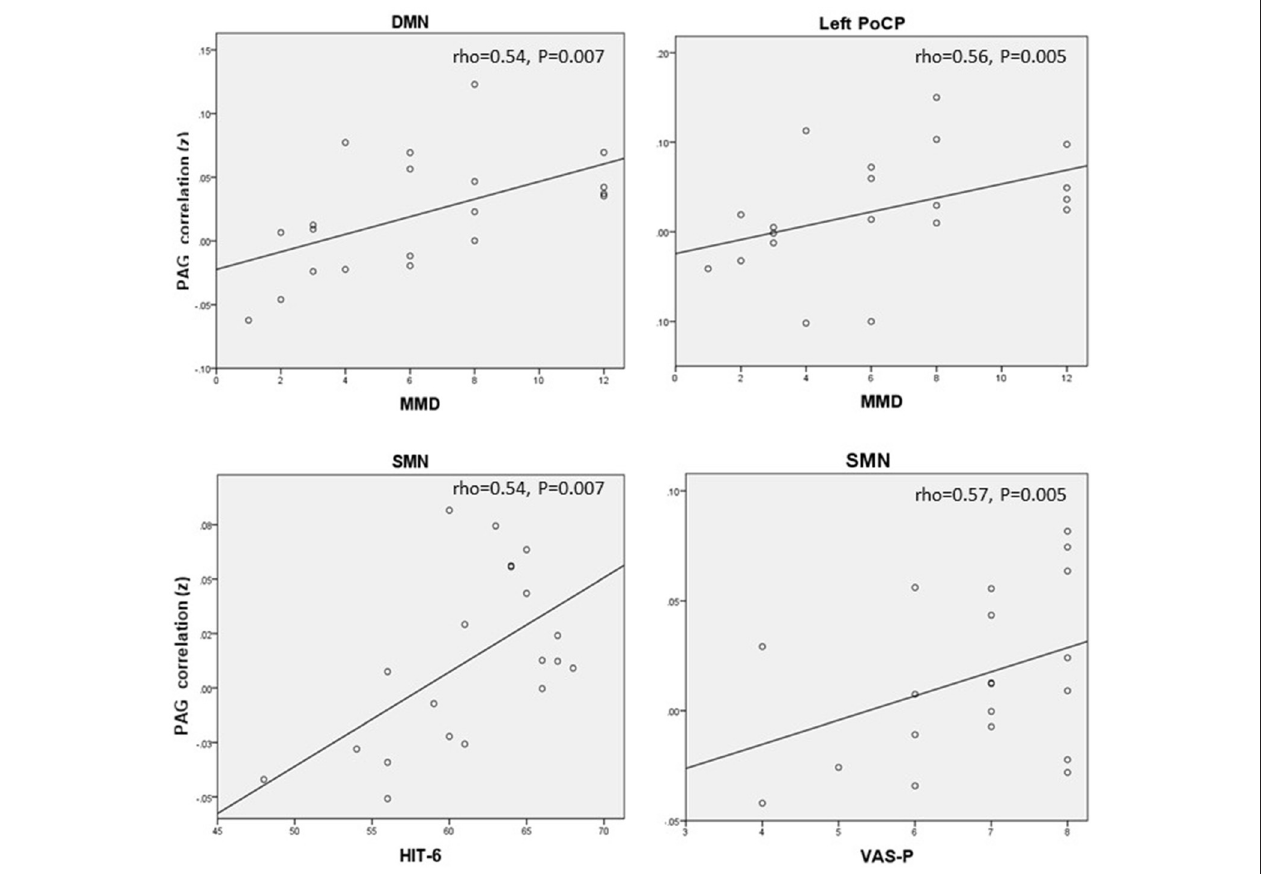
FIGURE 4 | Correlations between PAG RS-FC and clinical assessment scores. MMD, Monthly migraine days; HIT-6, six-item headache impact; VAS-P, visual analog scale.